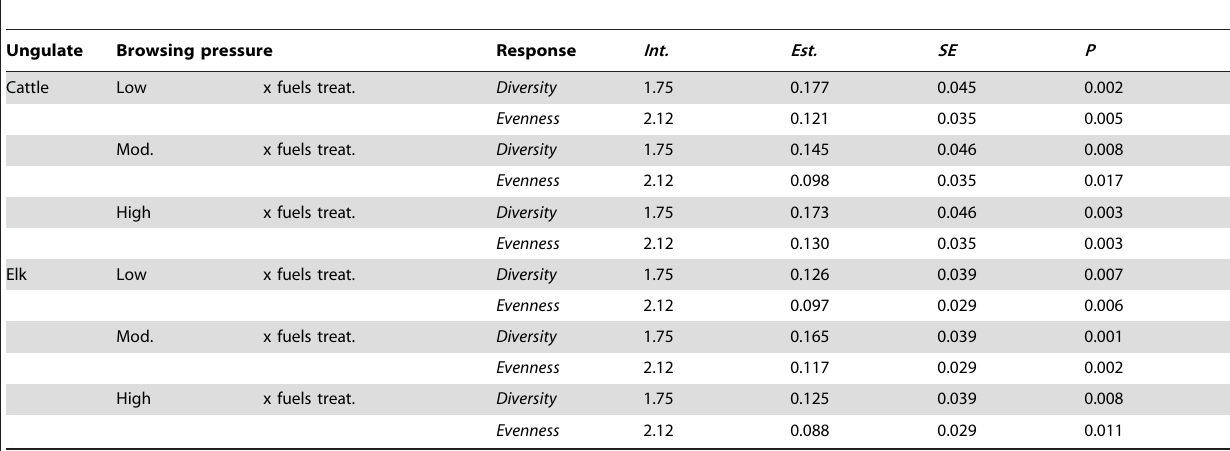
Table 1. Mixed model results showing intercept ( Int. ), model coefficients, estimate ( Est. ) and standard error ( SE ), and P-value ( P ) of interaction effects between fuels treatment and browsing pressure on shrub species diversity and evenness.